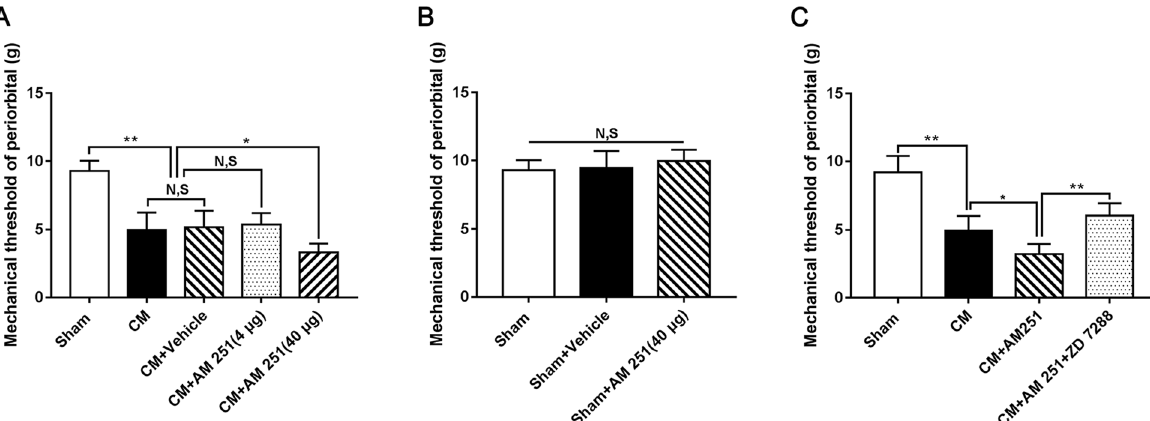
Fig. 9 The influence of AM 251 and ZD 7288 on hyperalgesia in CM rats. A The mechanical pain thresholds of the periorbital region in the CM group were materially lower than in the Sham group, and there was no obvious difference between the CM and CM Vehicle groups. Compared + to the CM Vehicle group, the mechanical pain thresholds of the periorbital region in the CM AM 251 (40 μg) group were visibly decreased. The + + mechanical pain thresholds of the periorbital region in the CM Vehicle group were indistinguishable from the CM AM 251 (4 μg) group. ( n 6/ + + = group, * p < 0.05, ** p < 0.01, N, S, not significant). B No substantial difference was observed in the mechanical pain thresholds of the periorbital region among the Sham, Sham Vehicle, and Sham AM 251 (40 μg) groups. ( n 6/group, N, S, not significant). C The mechanical pain thresholds + + = of the periorbital region were robustly decreased in the CM group compared with those in the Sham group, and the mechanical pain thresholds of the periorbital region in the CM AM 251 group were further drastically reduced compared to those the CM group. However, The mechanical + pain thresholds of the periorbital region were significantly increased in the CM AM 251 ZD 7288 group compared to those in the CM AM 251 + + + group. ( n 6/group, * p < 0.05, ** p < 0.01, N, S, not significant) =